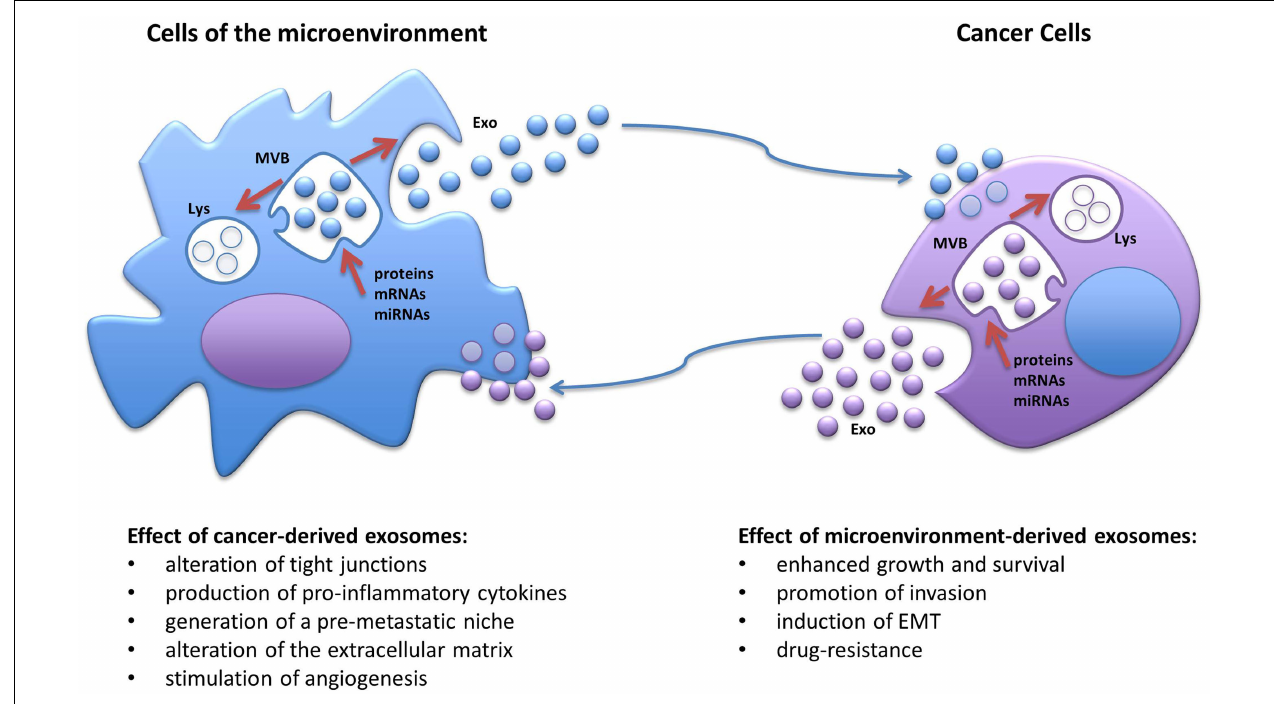
FIGURE 1 | Schematic representation of the biogenesis of exosomes and the cross-talk between cancer cells and the cells of the tumor microenvironment . MVB, multivesicular body; Lys, lysosome; EMT, epithelial-to-mesenchymal transitions; Exo, exosomes.